Question: Summarize what this figure shows in one sentence.
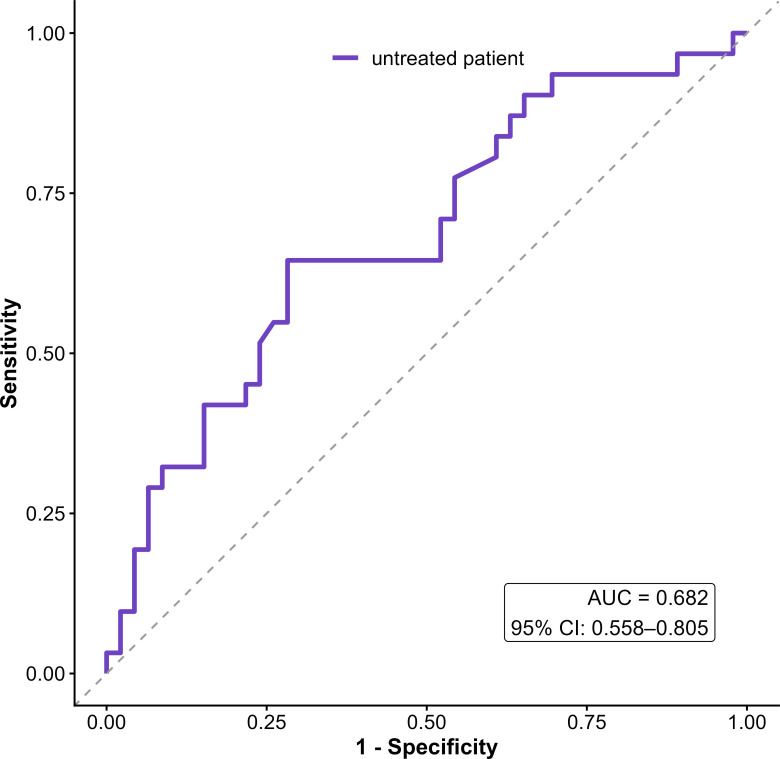
Answer: ROC curve analysis of mNGS RPTM for predicting respiratory deterioration risk in untreated patients.